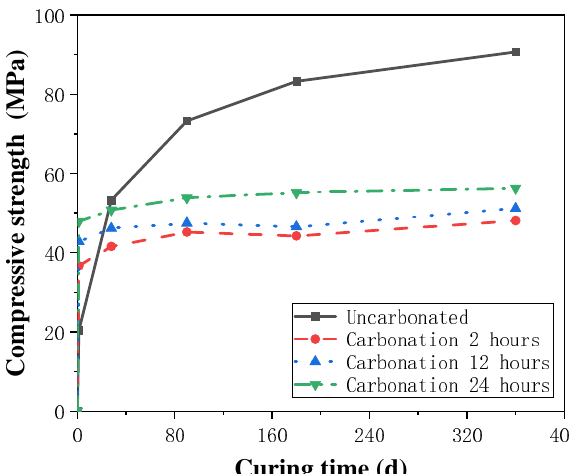
Figure 8. Variation in compressive strength with age growth of concrete with 50% fly ash content after carbonation curing [59].